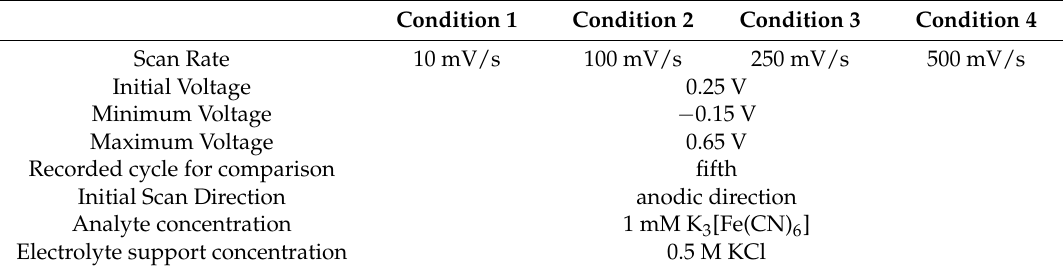
Table 3. CV conditions for each experiment.